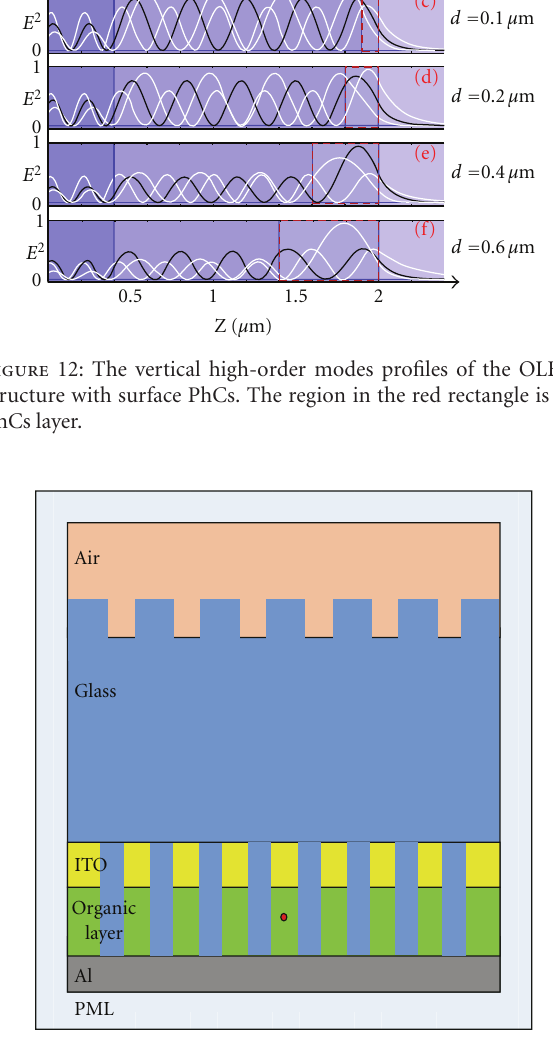
Figure 13: Schematics of optimized OLED structure with embed- ded PhCs and surface